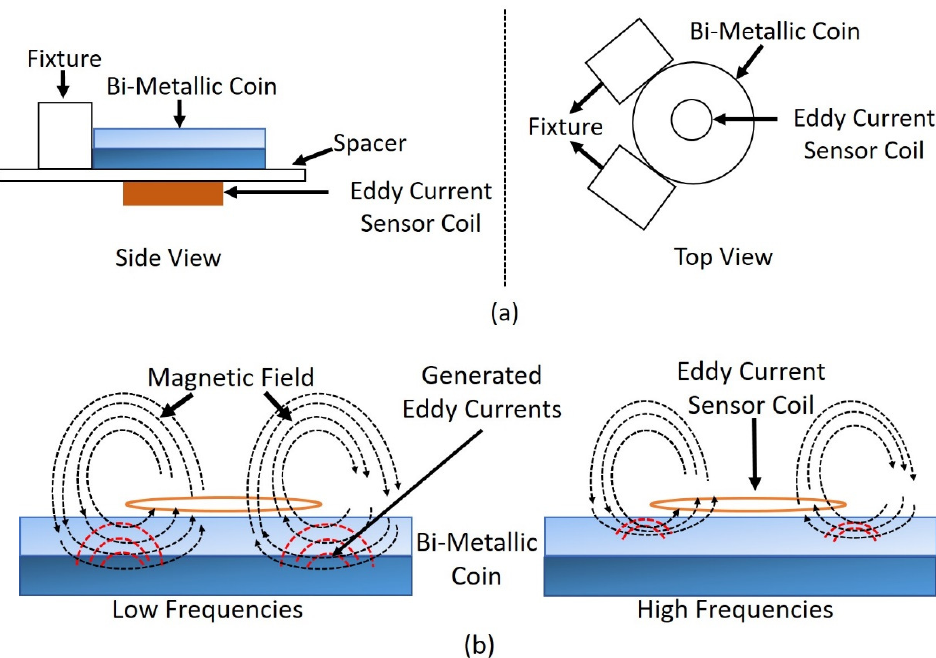
Figure 2. Representation of Eddy Current Sensor Coil over Bi-Metallic Coin ( a ) Schematic of Measurement Set-Up. ( b ) Side View of Magnetic Field Excitation at Different Frequencies. The coins were measured on both the obverse side and the reverse side at varying angles each spanned at 45° from 0° to 360° to prove the rotation invariance of the coin irrespective of the rotated placement angle over the coil. Figure 3 shows the real part of inductance spectra for EUR 2 coins measured at different angles, it can be seen that the inductance spectra overlap with each other and have similar inductance irrespective of the placement angle of the coin which proves that there is no dependency on the direction of placement of coin above the coil. The different measured inductance spectra of both coins at different angles result in variations of the inductance spectra. The statistics ‘mean and standard deviation’ from the variation of the inductance spectra can be calculated which contributes to the generation of synthetic dataset cluster by extracting the magnetic properties of both bi-metallic coins in different layers using an analytical model, which is explained in a later stage in this section.